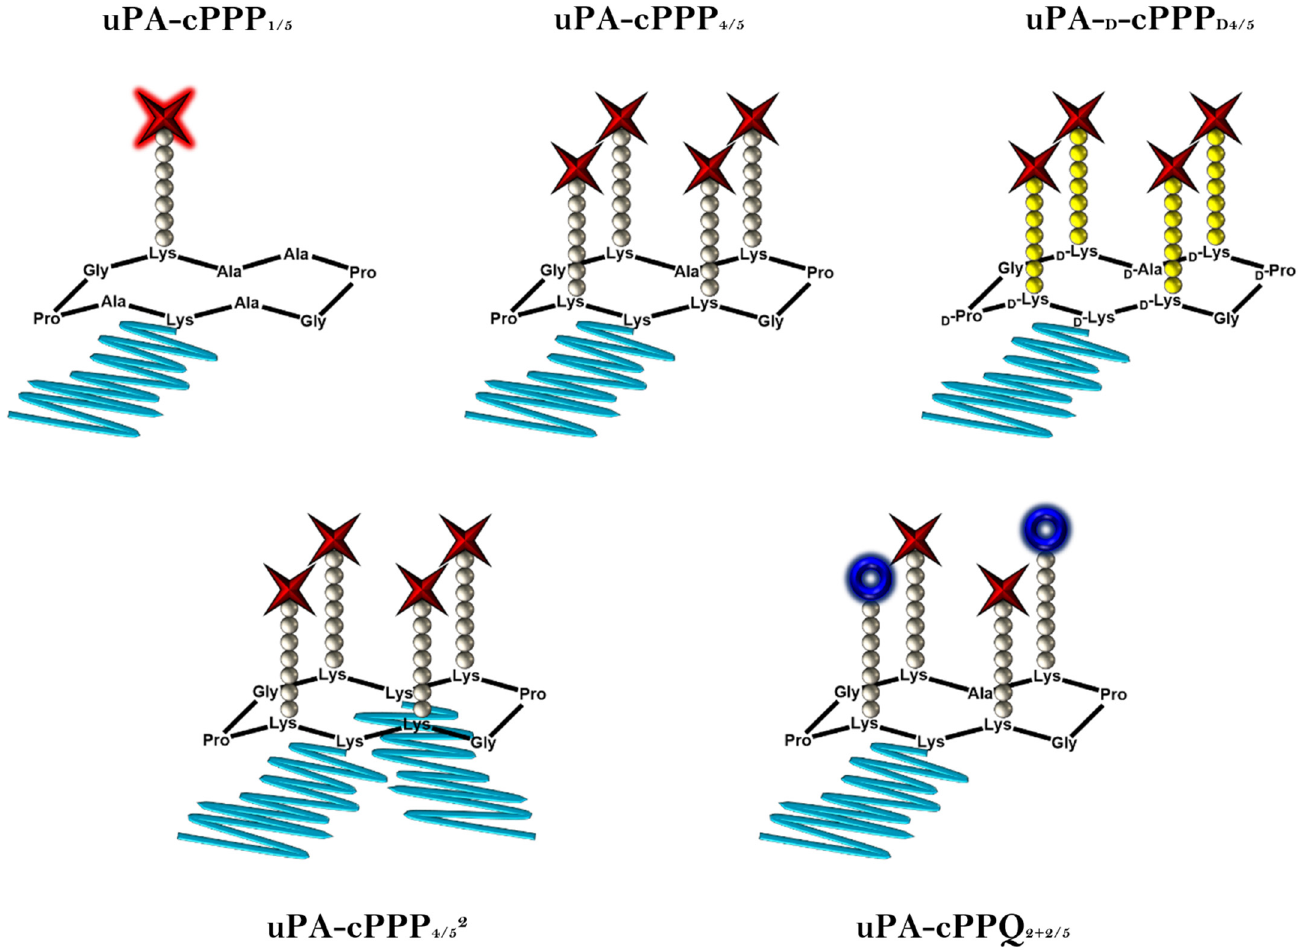
Figure 1. Schematic representations of the five prodrugs. Red stars stand for Pha moieties, blue crowns stand for BHQ3 moieties, grey and yellow balls stand, respectively, for L - or D -amino acids constituting the peptidic linkers and blue lines stand for PEG chains (5 kDa).